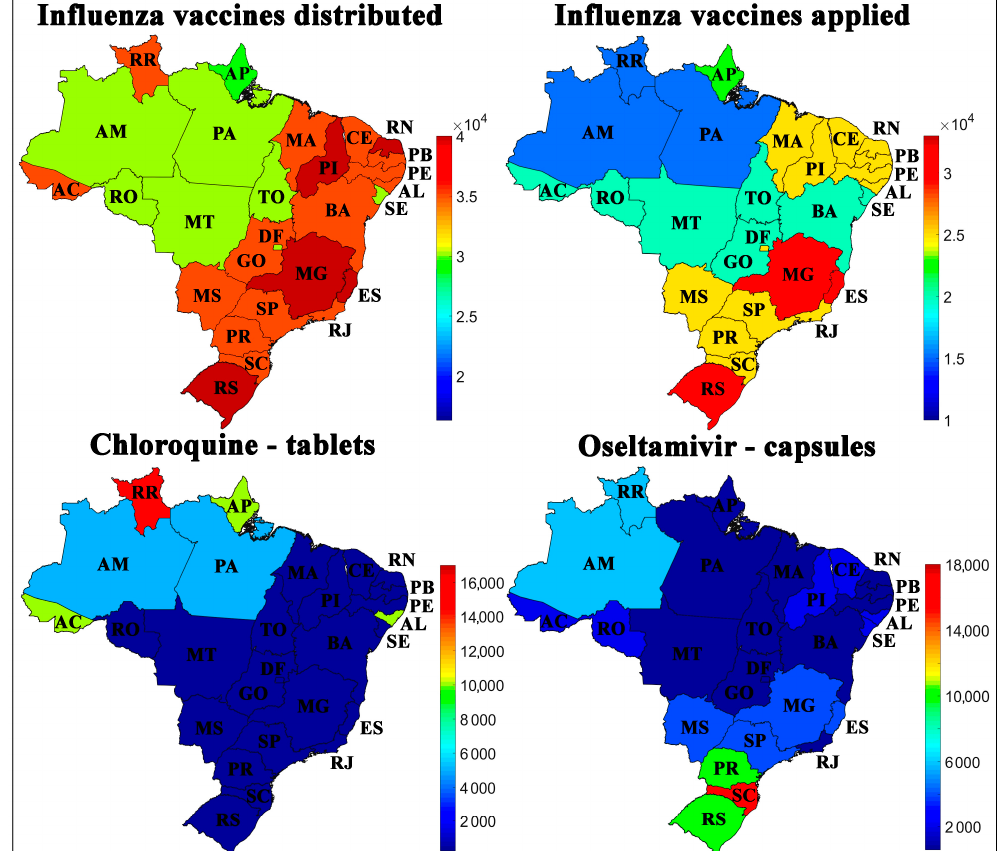
Figure 5. Geographical distribution of influenza vaccines distributed, influenza vaccines applied, chloroquine tablets, and oseltamivir capsules available in Brazilian states per 100,000